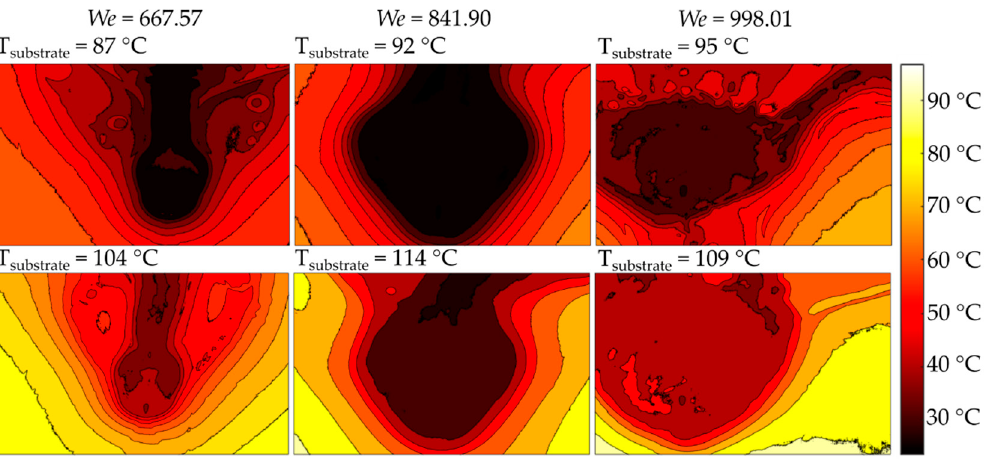
Figure 4. Steady-state thermographic images of ethanol droplet train impingement on the target glass surface at different Weber numbers for the surface temperature values of 85.00 °C to 115.00 °C.